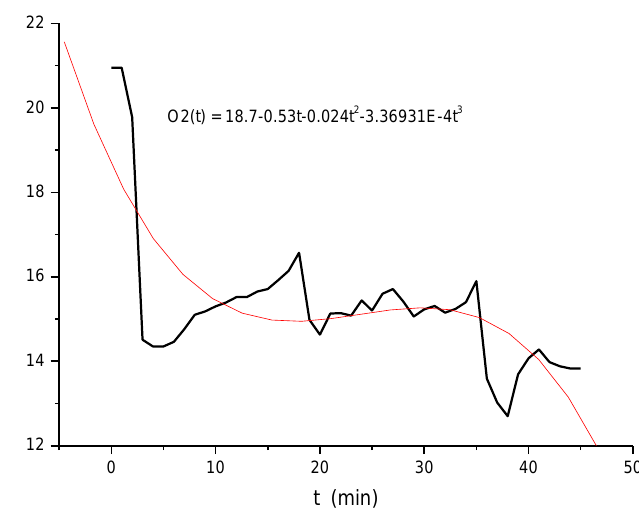
Figure 15. Dependence of CO 2 on operating time.